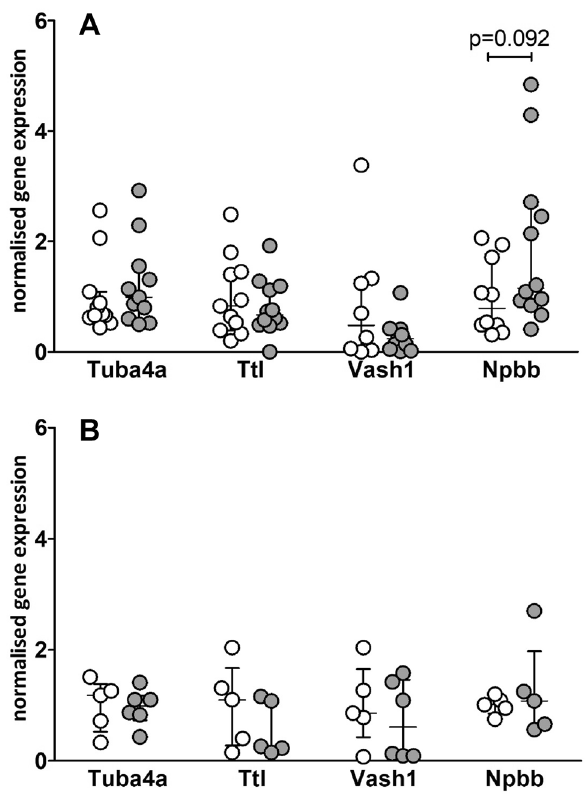
Figure 2. Gene expression of α-tubulin a4a (Tuba4a), tubulin tyrosine ligase (Ttl), vasohibin1 (Vash1) and NT-proBNP (Npbb) in left ventricle tissue of L-ZSF1 (white circles) and O-ZSF1 (grey circles) after 20 weeks ( A ) and 32 weeks ( B ). Y-axis shows arbitrary units of gene expression normalised to Hprt1 and to the mean signal of all L-ZSF1 rats. Scatter plots represent the median, 25th and 75th percentiles. p -values were calculated using Student’s t-test (for normal distribution) and non-parametric